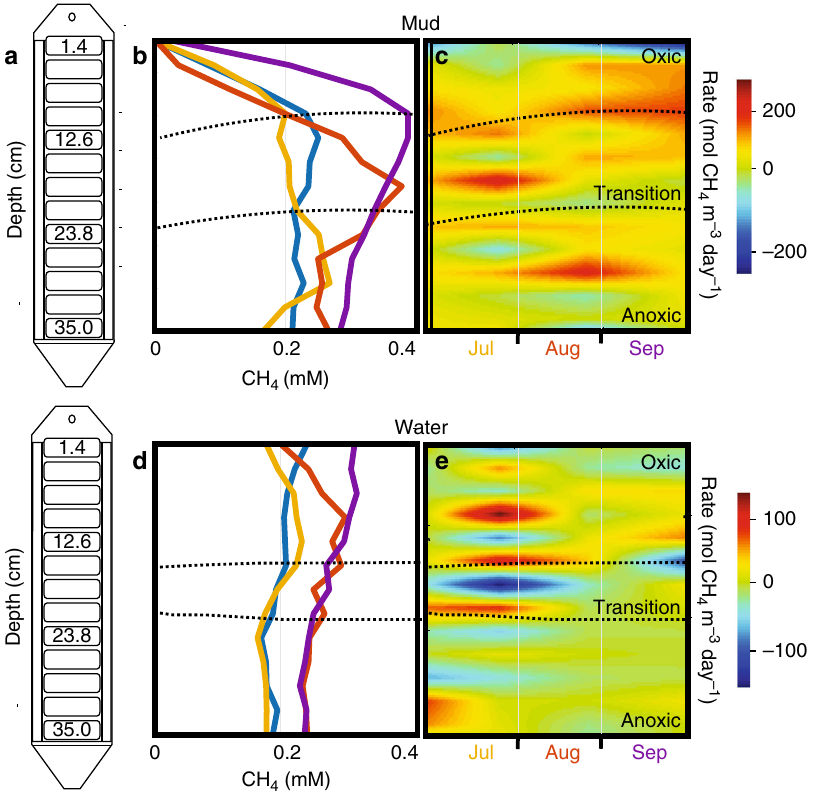
Fig. 1 Methane concentrations and production rates across soil depths. a Porewater dialysis peepers provide 2.8 cm resolved depth methane measurements. b , d Monthly in situ porewater dissolved methane concentrations in mud and water-covered soils with data collected from June (blue), July (yellow), August (red), and September (purple). Black dashed lines depict the 95% con fi dence interval for location of the oxic to anoxic transition. c , e . The calculated net methane volumetric fl uxes in soils columns from mud and water ecosites show seasonal methane production (orange and red) in oxic